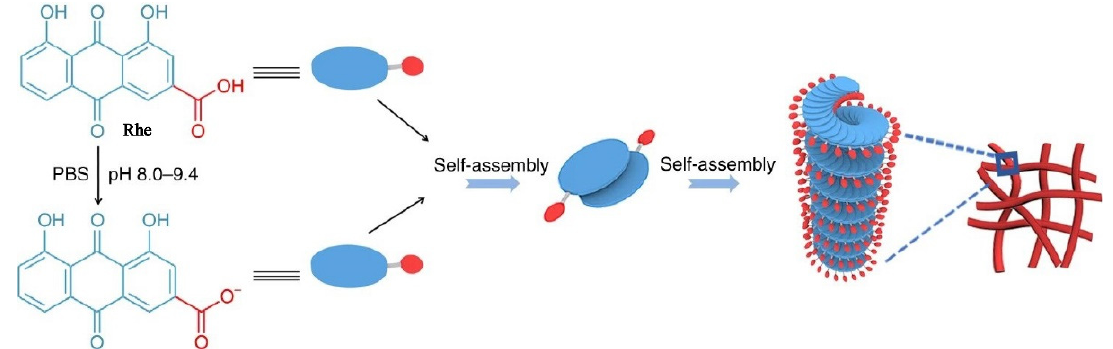
Figure 2. Schematic representation of the self-assembly mechanism of the rhein hydrogel [16] .